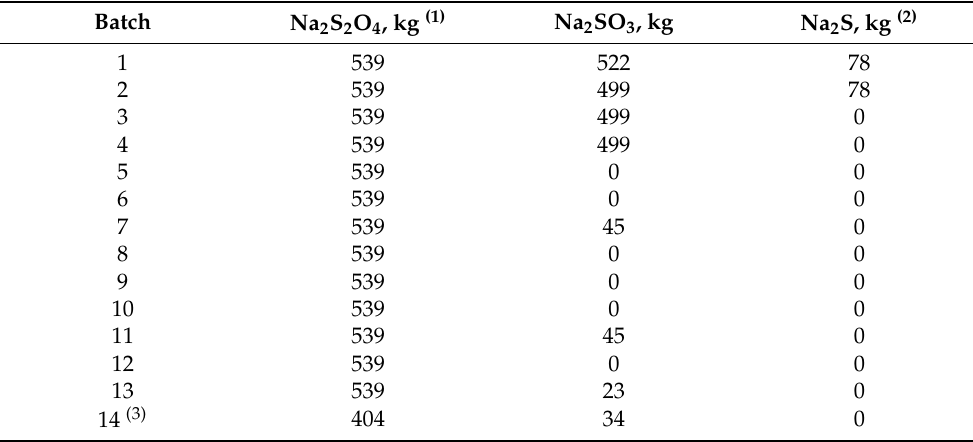
Table A7. Masses of chemicals added to each batch of dithionite amendment